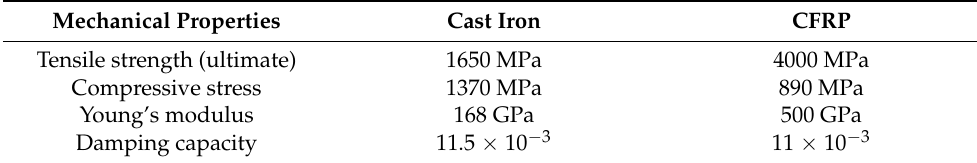
Table 3. Comparison of properties between cast iron and CFRP.